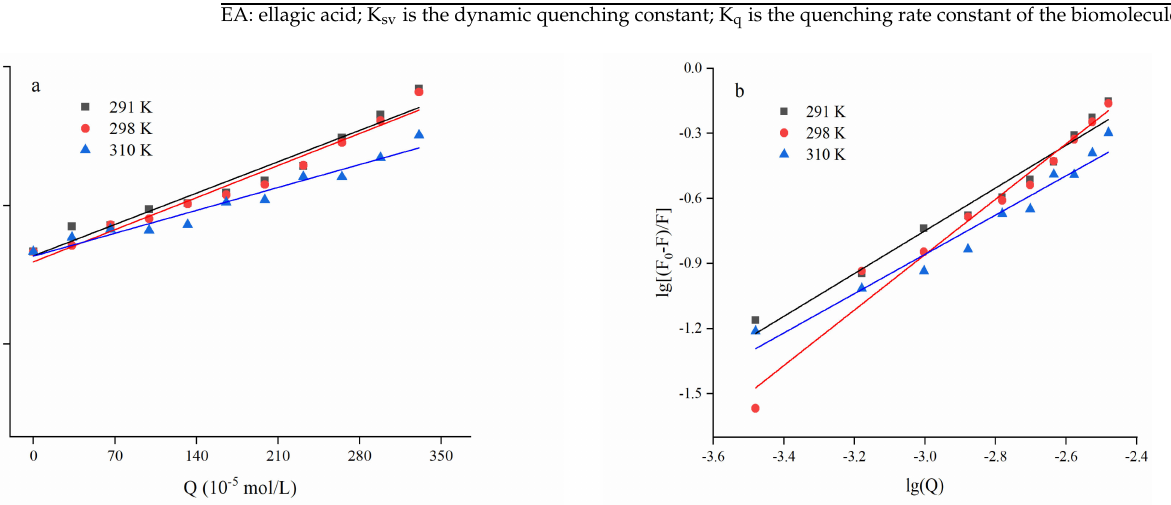
Figure 3. The plot for quenching on zein by EA at different temperatures. Note: ( a ): the Stern–Volmer plots; ( b ): the lg[(F 0 − F)/F] vs. lg(Q) plots for the binding of EA with zein; EA: ellagic acid; the concentration of zein is 0.05 mg/mL; EA concentration is 0, 0.1, 0.2, 0.3, 0.4, 0.5, 0.6, 0.7, 0.8, 0.9 and 1.0 mg/mL,